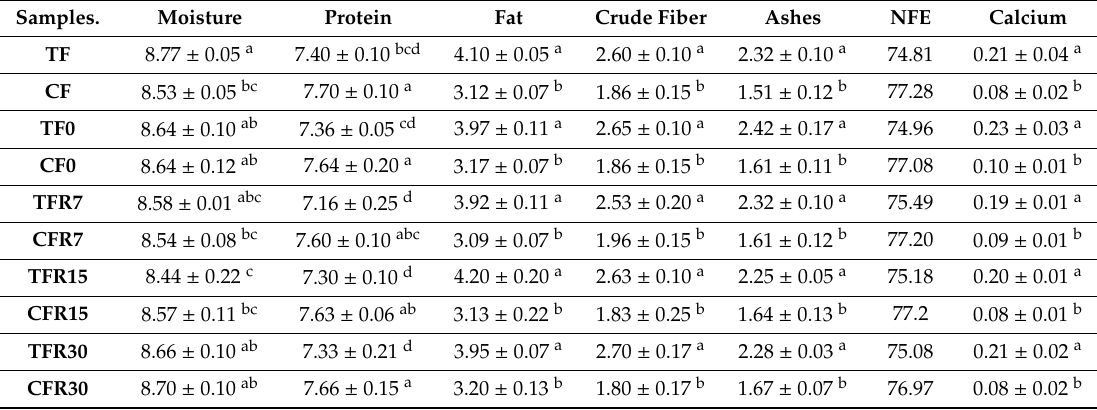
Table 2. Chemical proximate analysis and calcium content of corn flours and corn tortilla flours (g / 100 g).